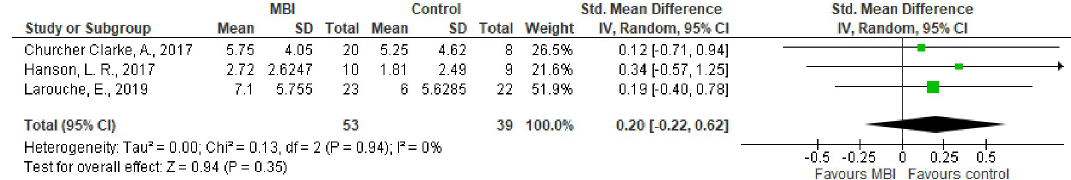
Fig 5. Forest plot of comparison: Depressive symptoms, MBI versus control after 6 to 10 weeks from the beginning of the intervention.